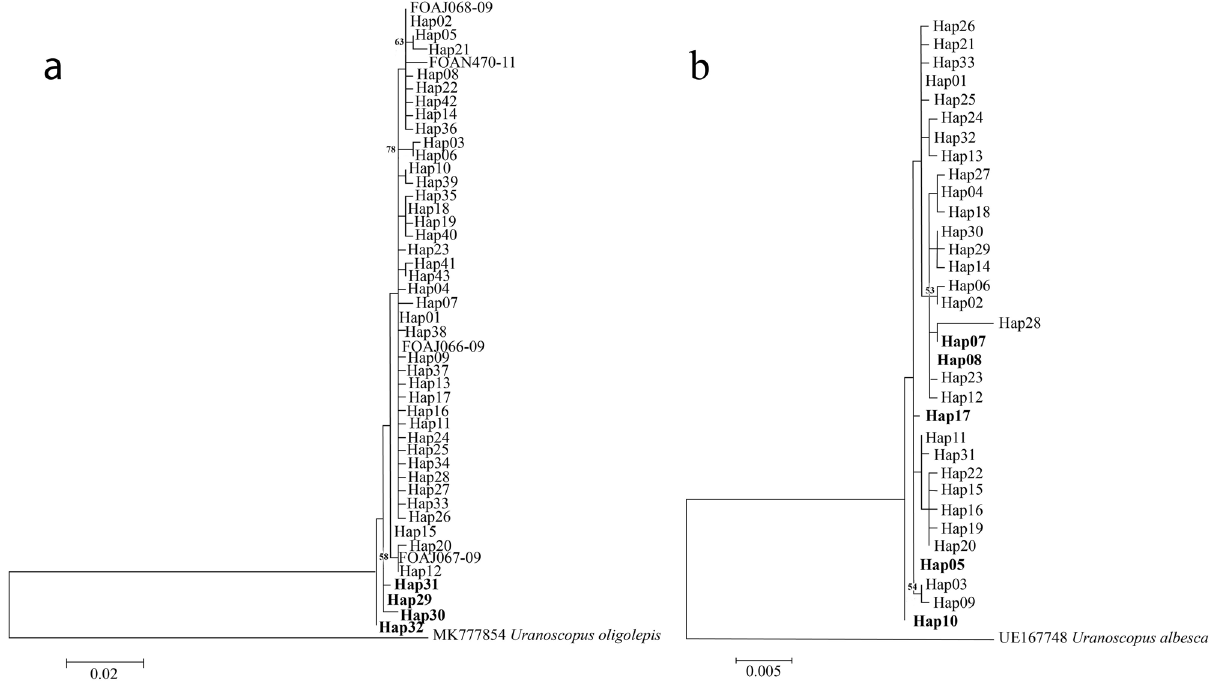
Figure 2. ML gene trees of Uranoscopus cognatus inferred from ( a ) CO1 ( b ) RAG1 sequences, constructed in MEGA 6.0 (https:// www. megas oftwa re. net/ resou rces). Branches were drawn to scale and bootstrap values < 50% were not shown. Haplotypes found in the west coast Thailand (WCT) were bold. FOAJ066-09, FOAJ067-09, FOAJ068-09 and FOAN470-11 were from Indonesia (BOLD